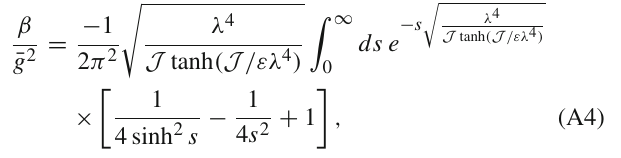
The solution (A8) is an oscillatory quasi-harmonic. 2 function in